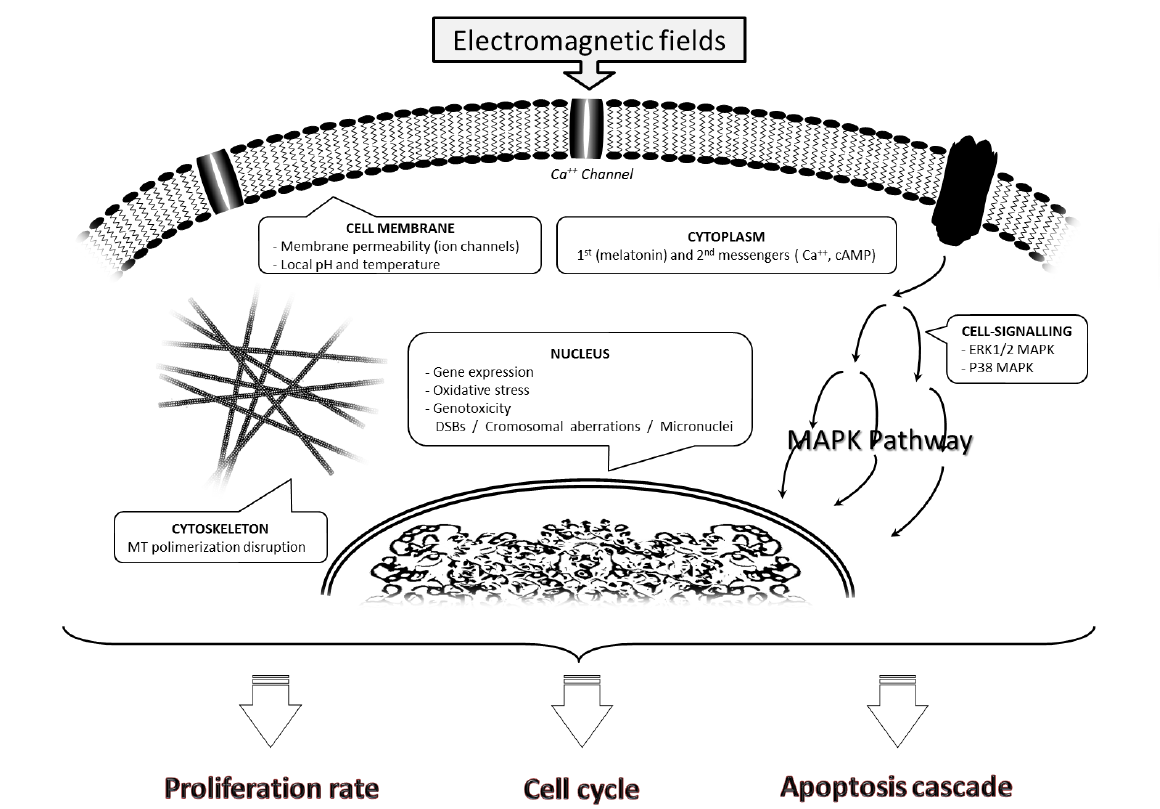
Figure 1. Main effects on the cell after exposure to electromagnetic fields (EMFs). EMFs alter the membrane structure and permeability of small molecules, such as Ca 2+ , causing changes in the local pH and/or temperature, and can also reorganize cytoskeleton components. It has been suggested that microtubule polymerization may be disrupted by external intermediate-frequency EMFs (100–300 kHz). The EMF-derived alteration of cell-signaling pathways (extracellular-regulated kinase (ERK)1/2 mitogen-activated protein kinase (MAPK) and P38 MAPK) would be provoked by the dysregulation of ions or by alterations in melatonin and second messengers, such as Ca 2+ or AMPc. EMF exposure also causes gene expression modifications and DNA-related damage involving free radical production, affecting DNA structure and provoking strand breaks and other chromosomal aberrations, such as micronucleus formation. All these changes ultimately influence cell cycle progression and the rate of proliferation and